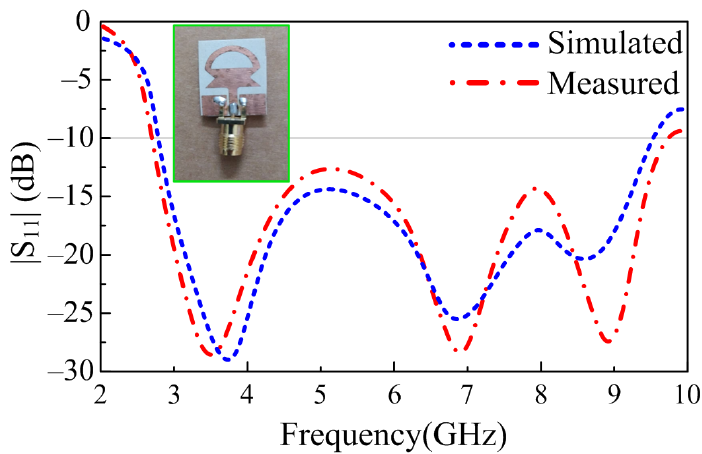
Figure 7. Comparison among the predicted and measured reflection coefficients of the proposed work.